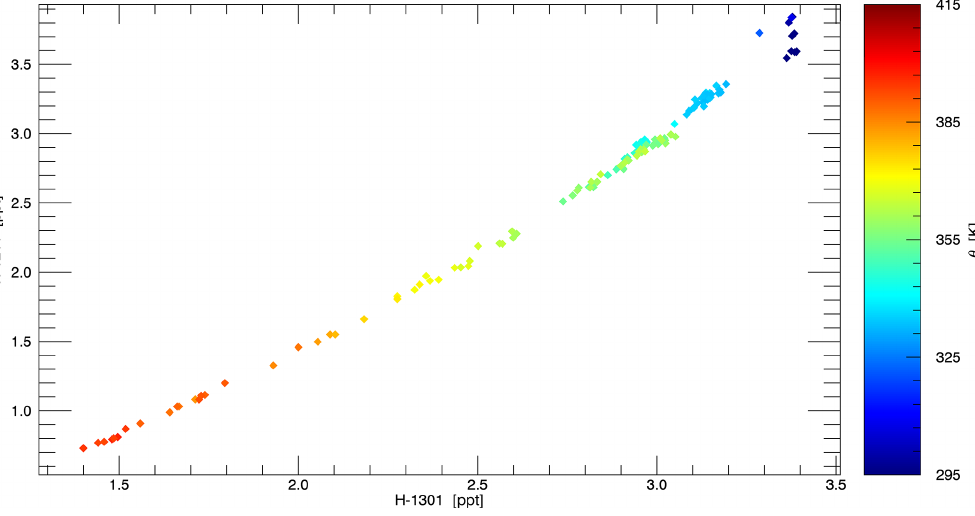
Figure 8. Tracer–tracer correlation of Halon 1301 (CBrF 3 , x axis) vs. Halon 1211 (CBrClF 2 , y axis). Colour code indicates potential temperature θ in [K]. Data were obtained during the POLSTRACC mission with the HALO aircraft, flight 160226a (PGS-14). Prelimi- nary data. Calibration scale of Halon 1301 and 1211: SIO-05. Preliminary measurement precision and calibration uncertainty: 0 . 4% / 1 . 7% (Halon 1301), 0 . 2% / 0 . 9% (Halon